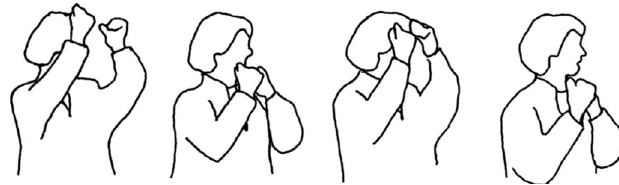
FIG. 2. Force-indicating depictive gestures. “The Earth has more pull